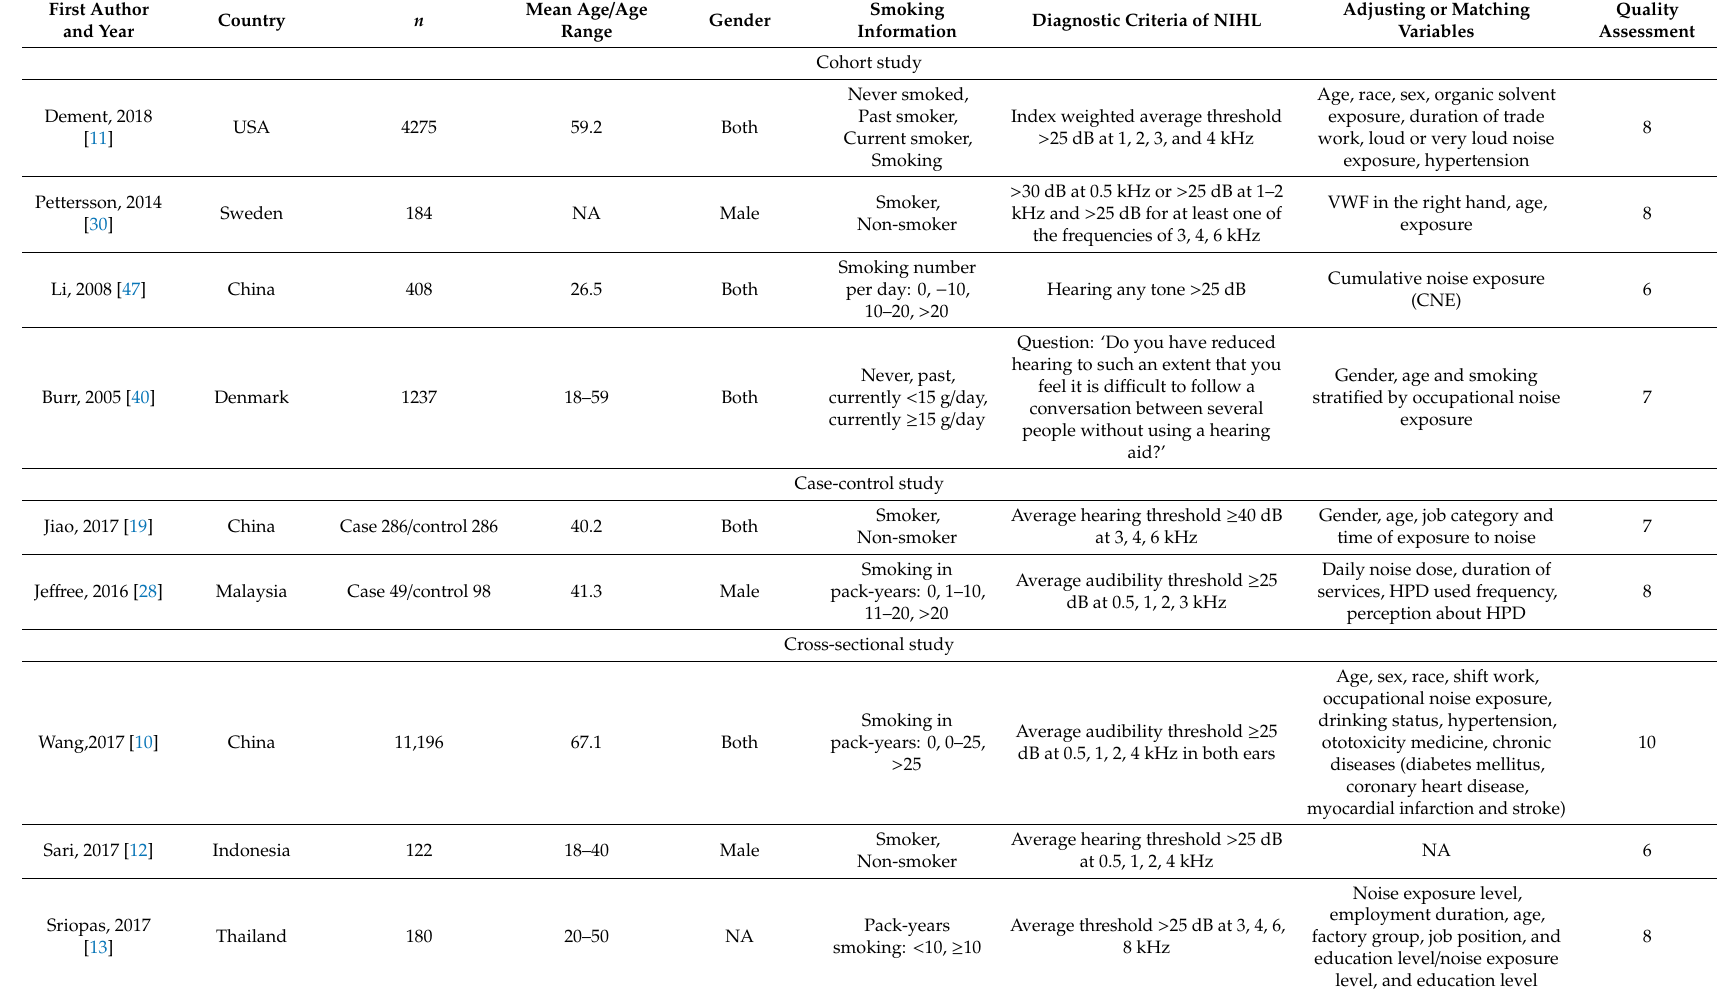
Table 1. Main characteristics of 28 included studies on smoking and NIHL